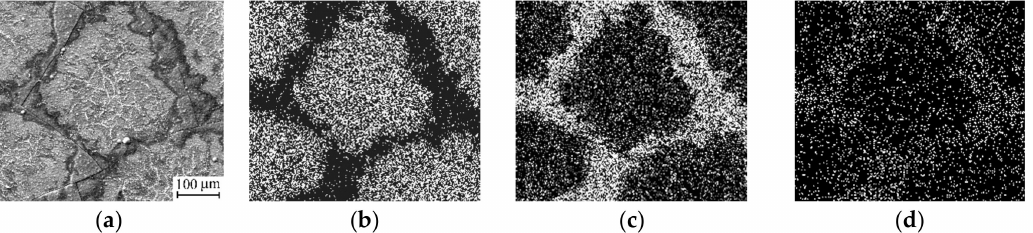
Figure 6. A SEM micrograph ( a ) and corresponding EDX maps of Cu ( b ), Si ( c ) and Al ( d ) for an Al 0.11 Si 0.89 N coating after 1 thermal cycle. White and black colors correspond to high and low elemental contents,